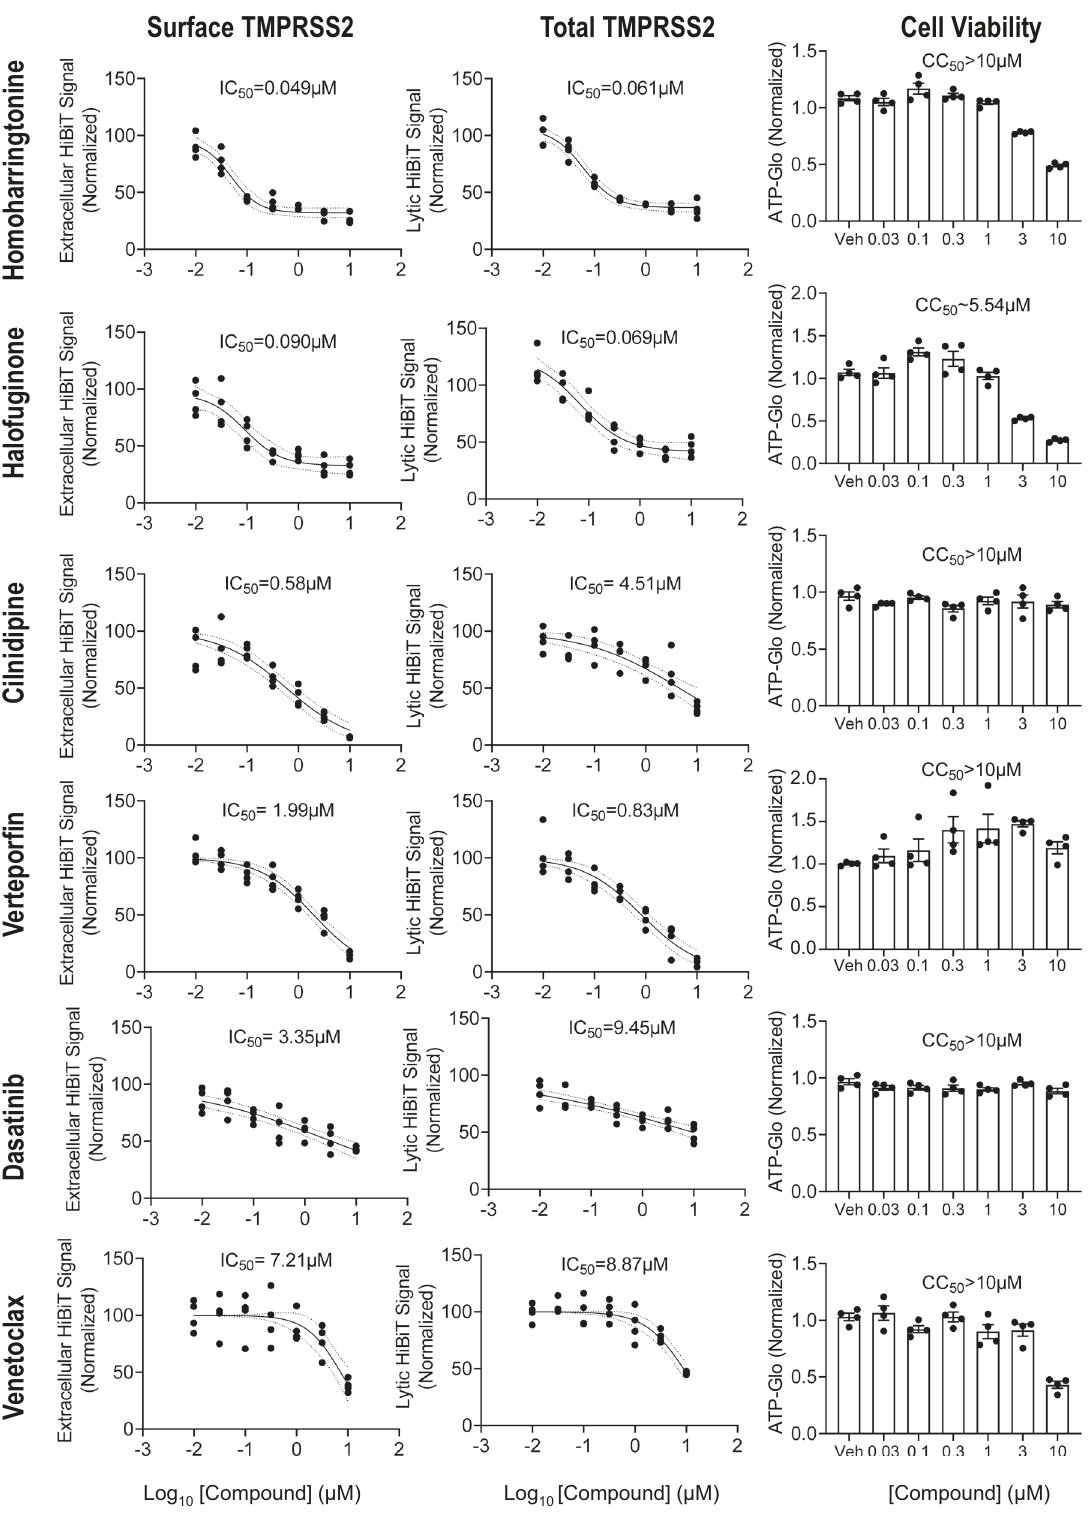
Fig. 3 Determination of the potency for a subset of identi fi ed compounds. A selection of six of the most promising drugs were assessed for their activity (IC50) to inhibit TMPRSS2 expression extracellularly ( fi rst column) or to inhibit total TMPRSS2 (middle column) in TMPRSS2-HiBiT-BEAS-2B cells. An assessment of cellular toxicity for each compound (CellTiter-Glo) is shown in the last column. The remaining activity pro fi les for other identi fi ed agents are found in the supplementary fi gures. Data are mean ± SEM ( n = 4 biologically independent samples). Data are plotted along with a sigmoidal model fi t, with dotted lines representing the 95% con fi dence interval. Estimated values of IC50 and CC50 (cytotoxicity concentration 50%) are